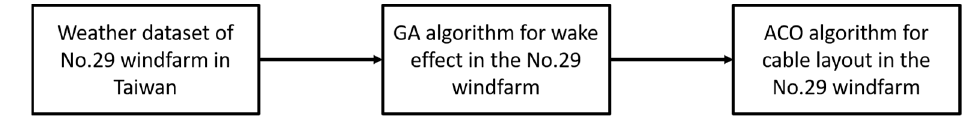
Figure 4. The experimental logistic schematic diagram.